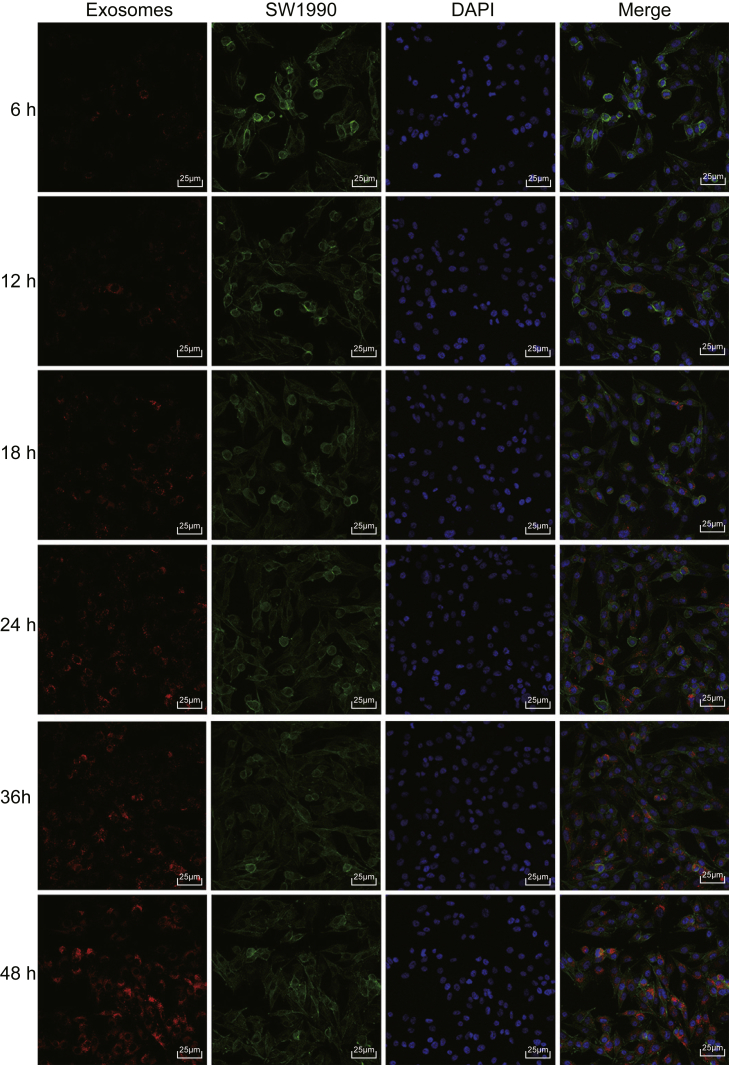
The Exosomes from NFs into SW1990 Cells Increased in a Time-Dependent Manner (×400)SW1990 cells were cocultured with PKH26-labeled exosomes (red). SW1990 cells were stained with FITC-conjugated phalloidin (green) and nuclei stained with DAPI (blue). The experiment was repeated 3 times independently.